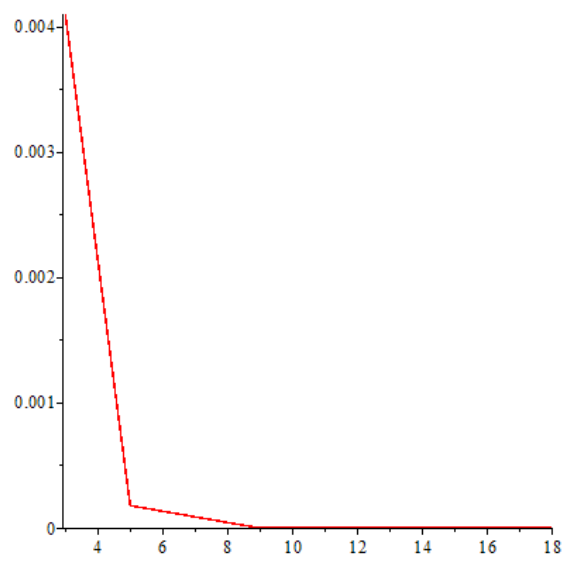
Figure 4. Presentation of (cid:107)V − V n (cid:107)